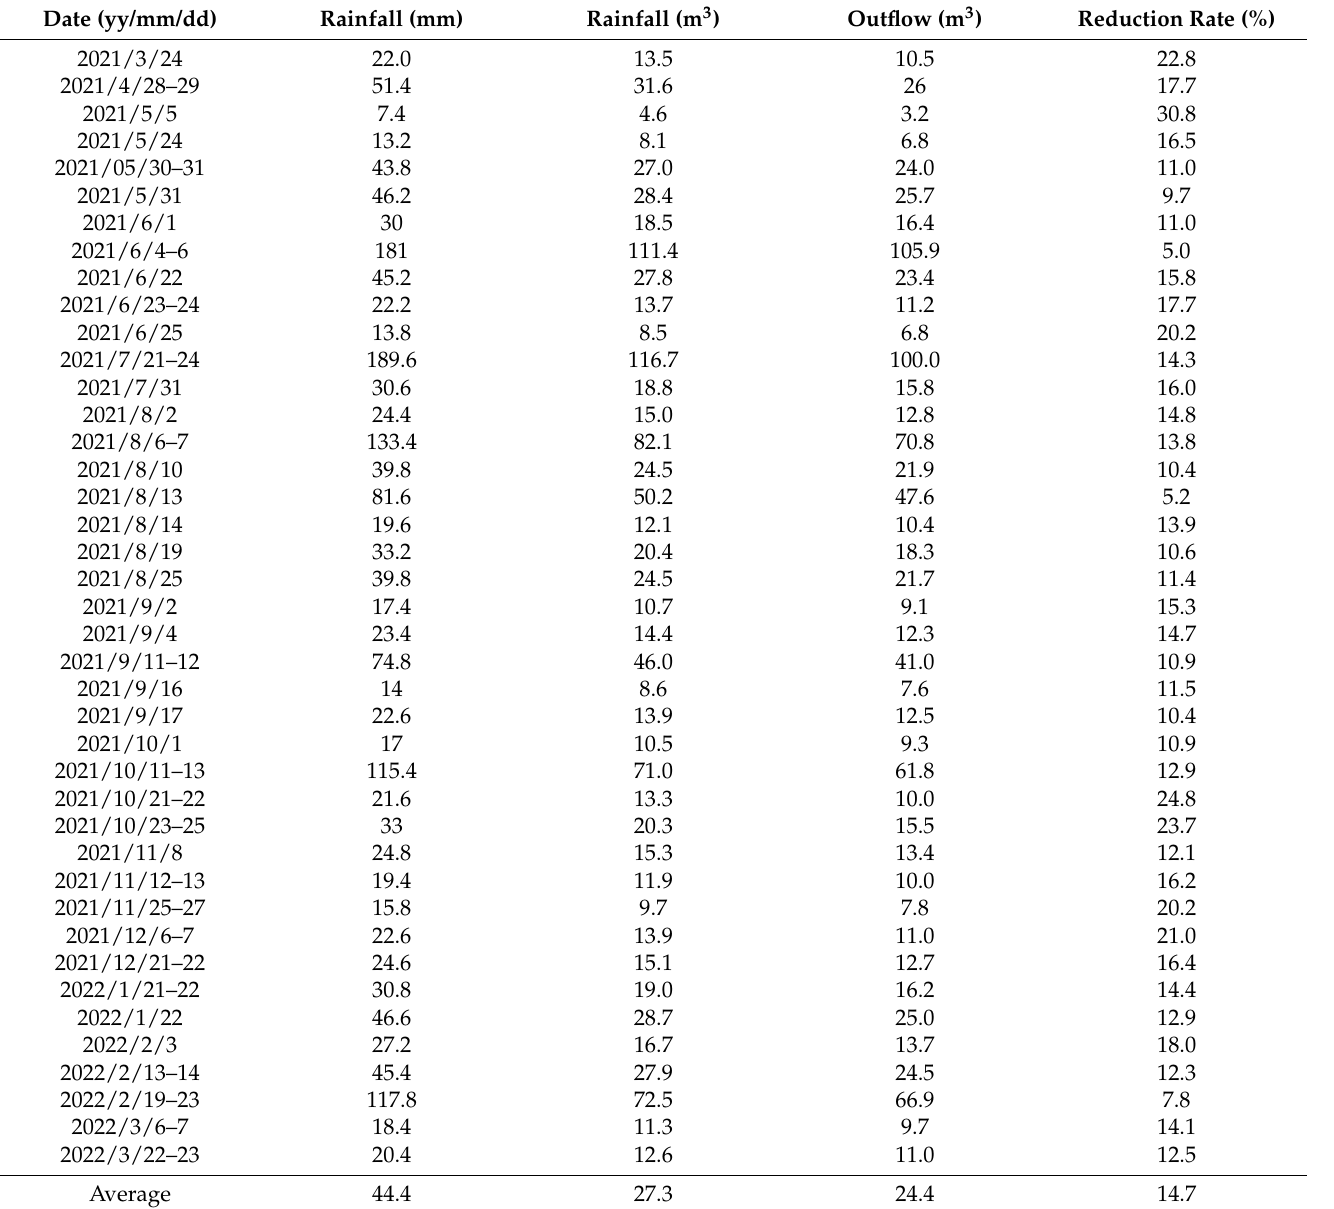
Table 1. Observed rainfall events at the permeable pavement